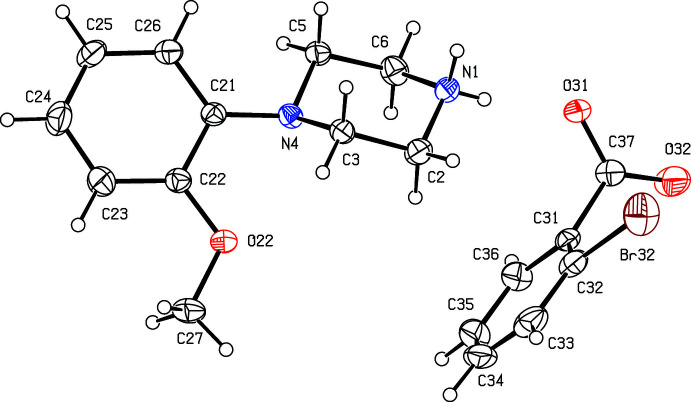
The independent components of compound (VI) showing the atom-labelling scheme. Displacement ellipsoids are drawn at the 30% probability level.